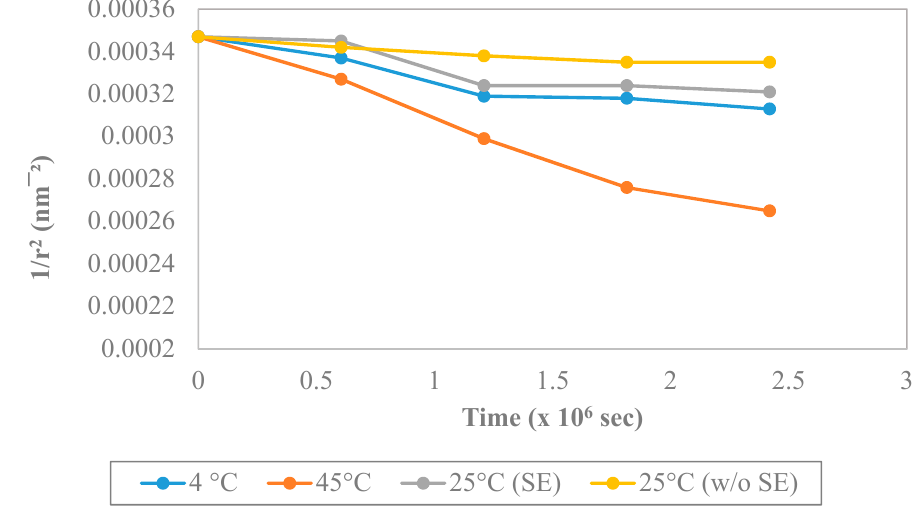
Figure 6. Graph of 1/r 2 vs. storage time.